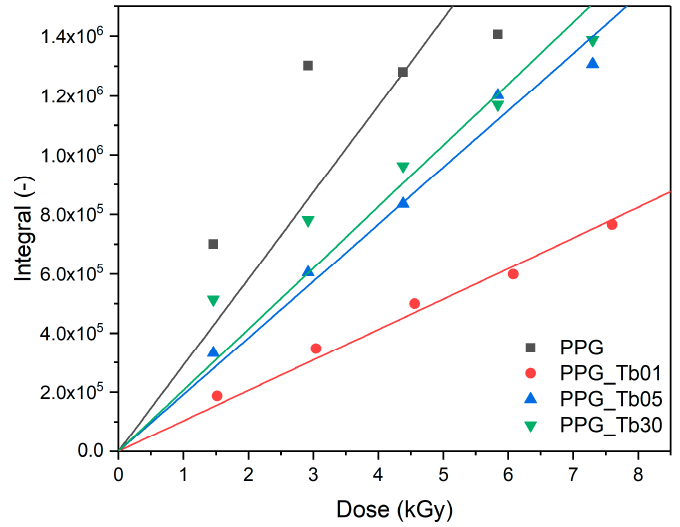
Figure 7. Dependencies of TL signal integral vs. dose absorbed for samples irradiated using gamma radiation (irradiation chamber); for PPG sample, TL glow curves were recorded without shutter.